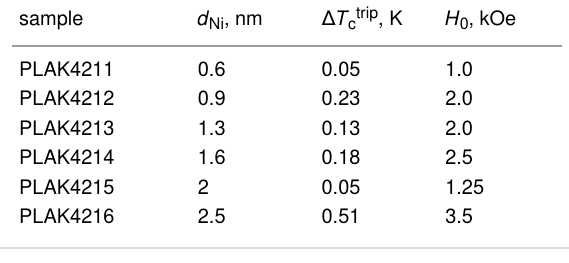
Table 1: Parameters of all studied samples with variable Ni layer thick- ness d Ni . is the maximum value of the triplet SSV effect as de- termined from the angular dependence T c ( α ) obtained at the field H 0 .